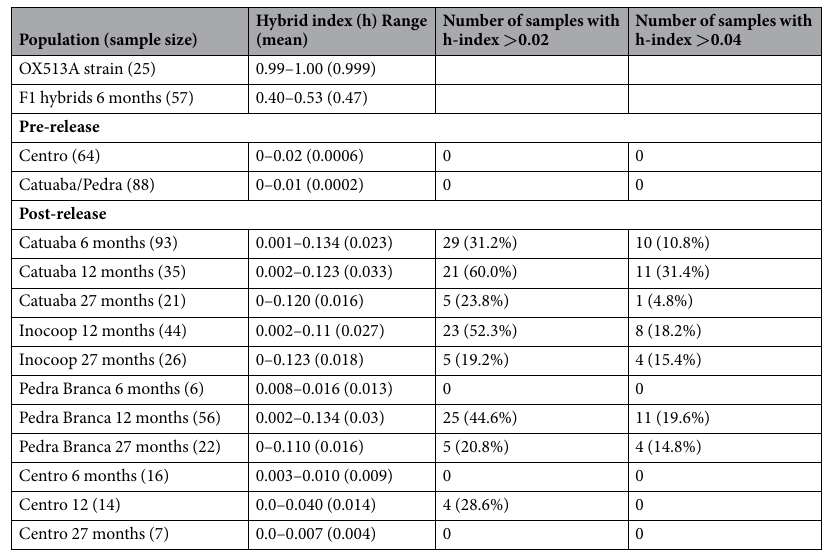
Table 1. Results of the “INTROGRESS” analysis as performed using the R package 10 . Two cutoffs for introgressed individuals: h = 0.02, the maximum observed in prerelease samples and h = 0.04, the maximum observed in Centro after